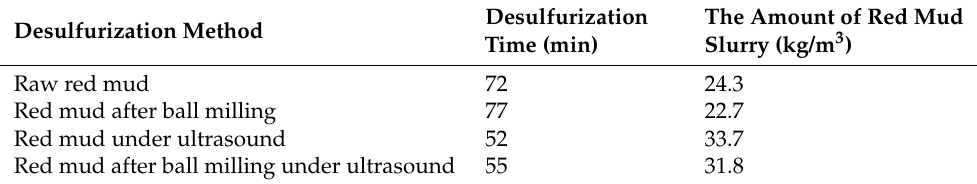
Table 2. The amount of red mud slurry required to absorb 1 kg of SO 2. Desulfurization Method